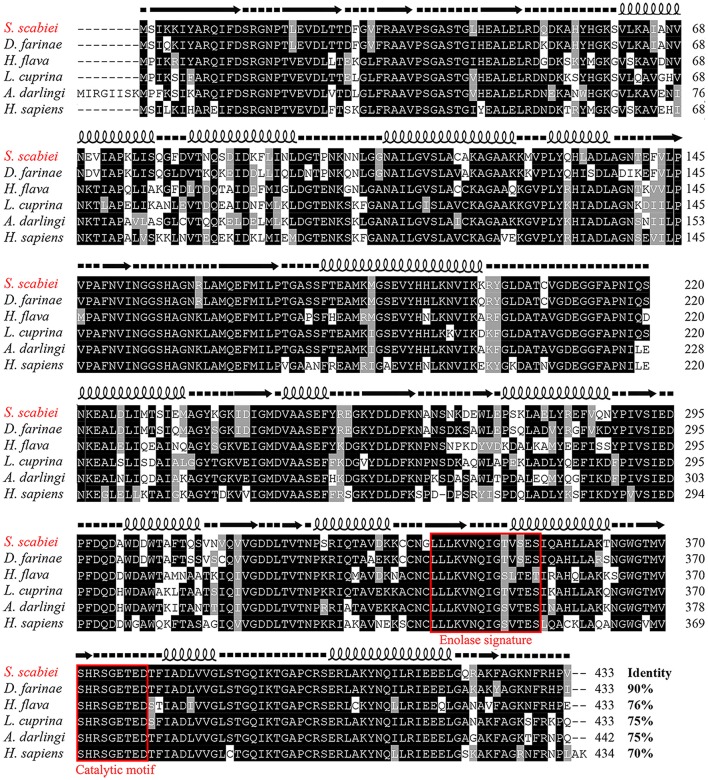
Sequence alignment of S. scabiei enolase (Ssc-eno). Alignments of the deduced amino acid sequence of Ssc-eno (KPM02829.1) with homologous proteins from arthropods (Dermatophagoides farinae: AHV90299.1; Lucilia cuprina: KNC30153.1; Haemaphysalis flava, AIS82610.1; Anopheles darlingi, ETN65833.1) and humans (alpha-enolase from Homo sapiens: AAY43128.1) were performed using Clustal X software version 1.83 and then shaded by BOXshade version 3.21. Predicted secondary structure elements of Ssc-eno, including coils, strands, and helices, are shown above the alignment as dashed lines, straight lines, and loops, respectively. The enolase signature motif and catalytic motif are enclosed in red boxes.